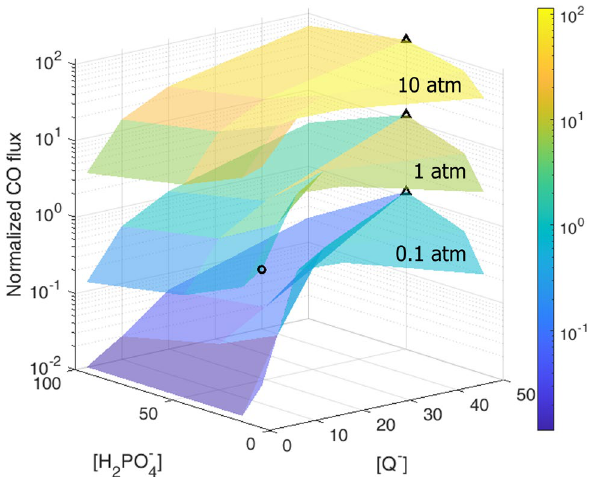
Fig. 3 Dependence of the CO production on the initial concentration of the reactants. Normalized CO production depending on the ini- = c 0 = 10,20,50,100 mM), the electron relays ( c 0 tial molar concentration of the buffer ( c 0 H HPO 2 − 4 2 PO − 4 = 0.1,1,10 atm). The flux is normalized to the 10:1 case for c 0 Q = c 0 Q − = 2.5 mM, c 0 external CO 2 pressure ( p CO 2 = 1 atm ( d n ∕d t = 3.599 × 10 − 7 mol m − 2 s − 1 ), black circle in the picture. The maximum CO produced at each pressure level is indicated p CO 2 with a triangle. The corresponding numerical values are reported in Supplementary file 1: Fig.